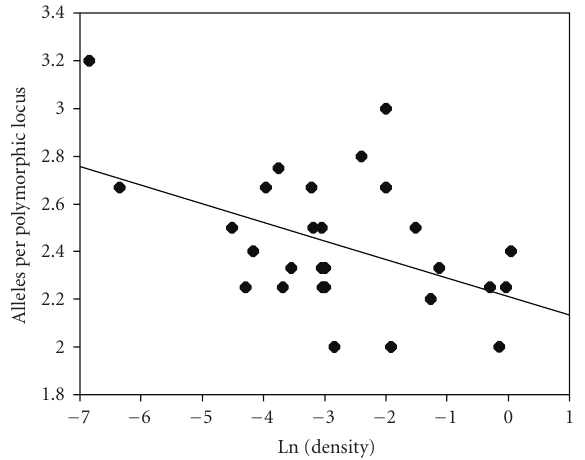
Figure 3: Alleles per polymorphic locus as a function of the natural log of population density per m 2 , for Liatris ohlingerae. r = − 0.465, P = . 010.